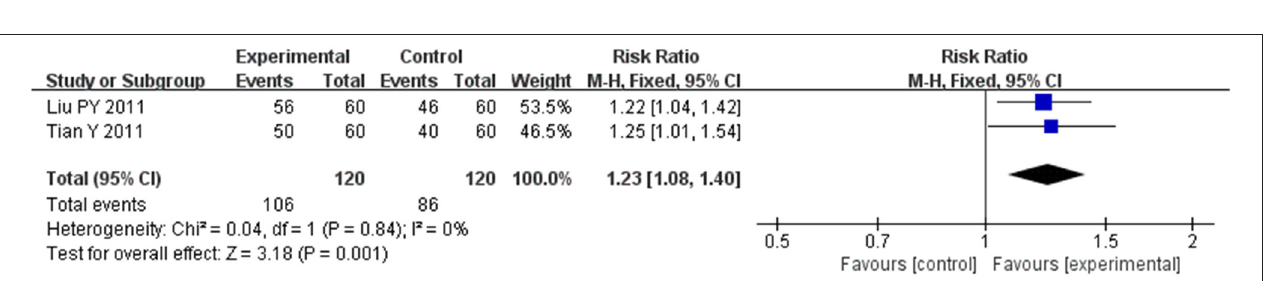
FIGURE 11 | Forest plot of the comparison between CHM and control for clinical efficacy rate as measured using cardiac function class of NYHA as defined in the Guidelines for clinical research of new Chinese medicine drugs.